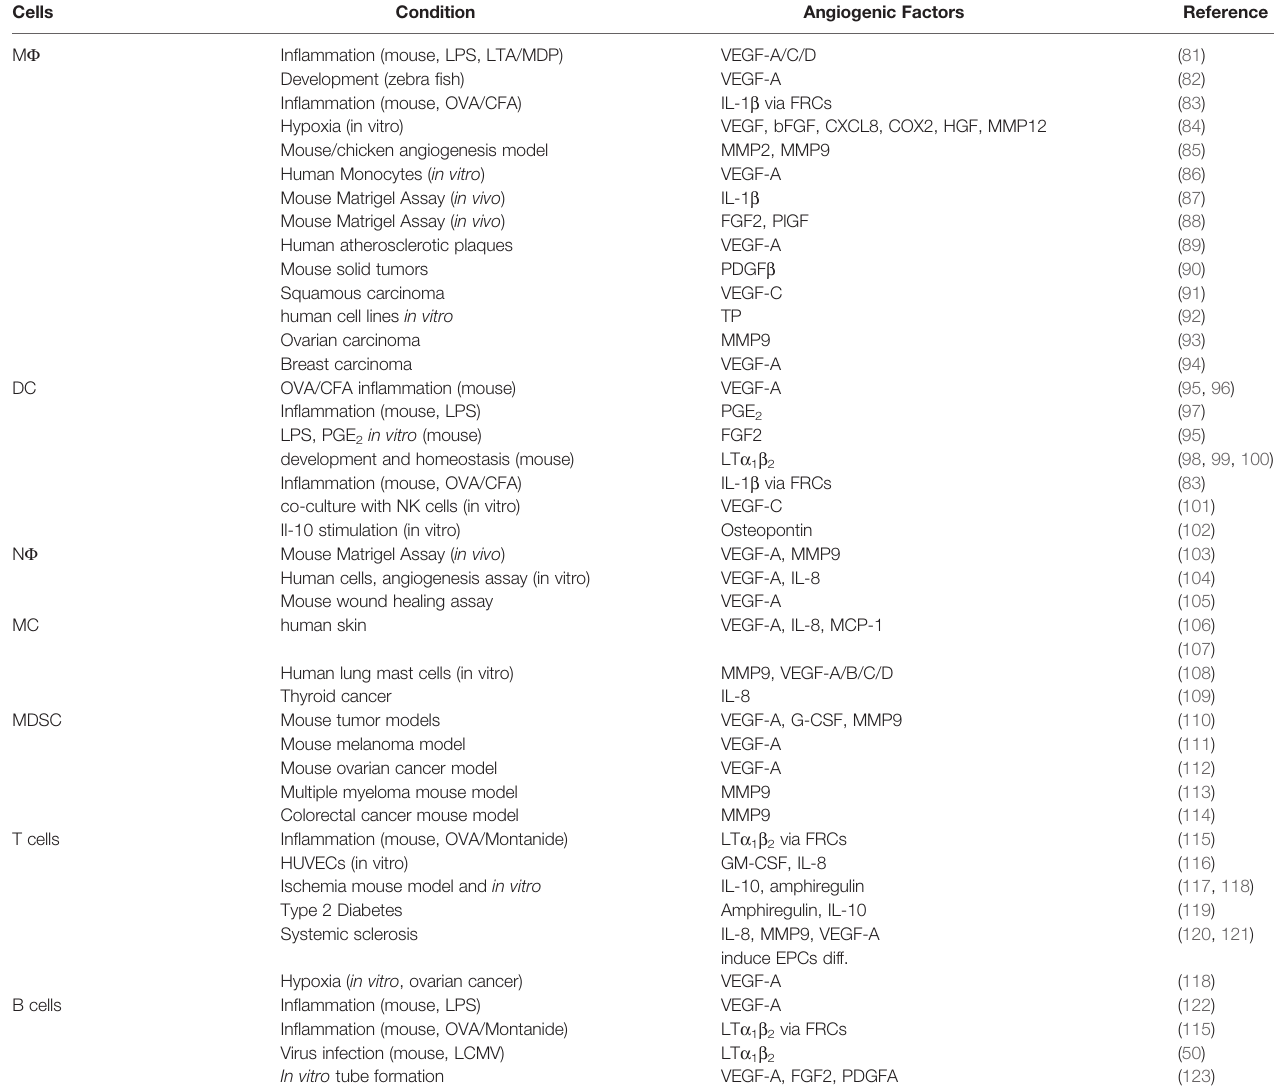
TABLE 1 | Immune cells derived pro-angiogenic factors.